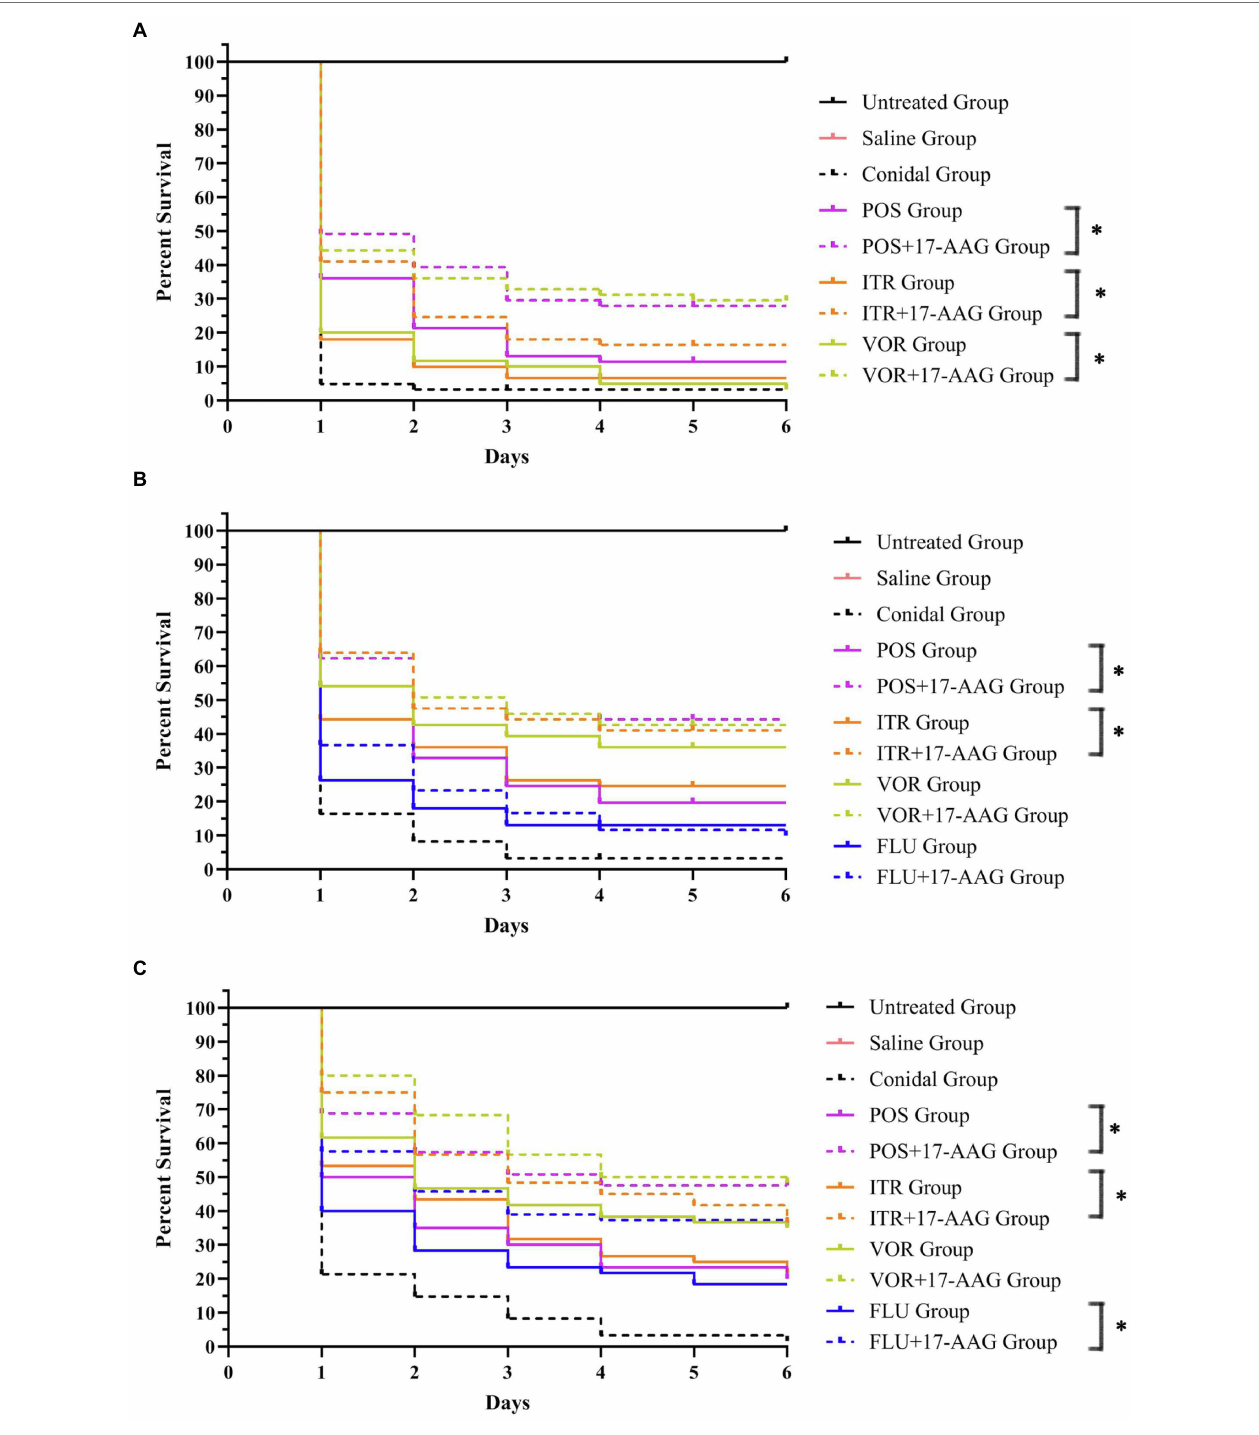
FIGURE 2 | Galleria mellonella survival curves following infection with Candida spp. (A) C. auris AR 382; (B) C. glabrate 05448; and (C) C. abicans R2. Untreated group, wild-type uninfected larvae; Saline group, wild-type larvae injected with saline; Conidial group, larvae infected with Candida without any treatment; itraconazole (ITC) group, Candida -infected larvae treated with ITC alone; voriconazole (VOR) group, Candida -infected larvae treated with VOR alone; posaconazole (POS) group, Candida -infected larvae treated with POS alone; fluconazole (FLU) group, Candida -infected larvae treated with FLU alone; 17-AAG + ITC group, Candida -infected larvae treated with 17-AAG combined with ITC; 17-AAG + VOR group, Candida -infected larvae treated with 17-AAG combined with VOR; 17- AAG + POS group, Candida -infected larvae treated with 17-AAG combined with POS. 17-AAG + FLU group, Candida -infected larvae treated with 17-AAG combined with FLU; * p <